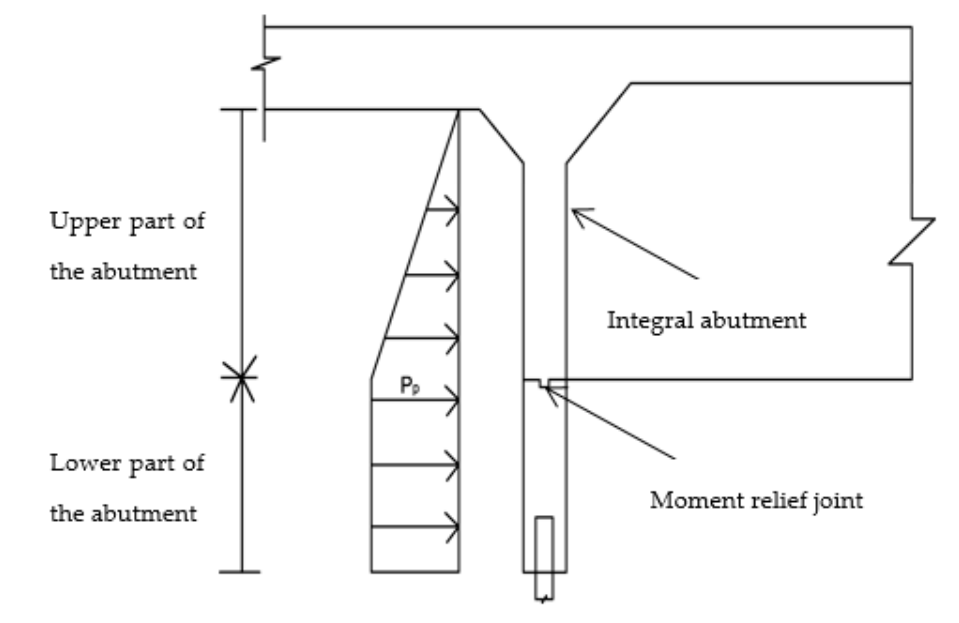
Figure A2. Earth pressure on integral abutment—Minnesota DOT [92].